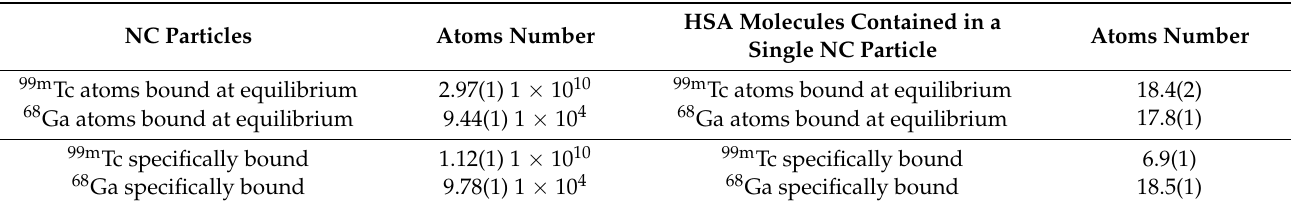
Table 2. Number of 99m Tc and 68 Ga atoms bound to a single nanocolloid particle and to the Human Serum Albumin molecules contained in each nanoparticle. Mean (SD).